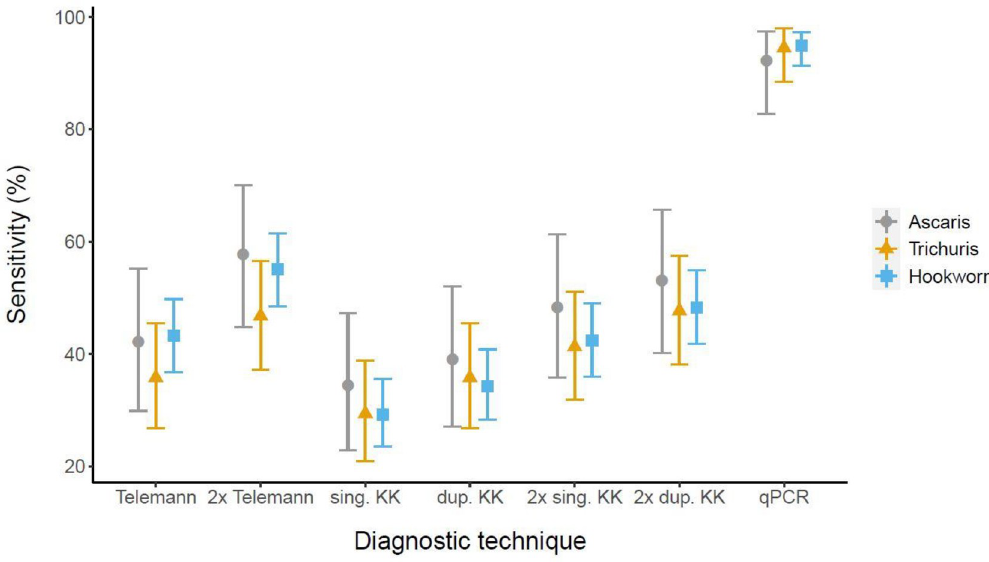
Fig 2. Estimated sensitivity and 95% confidence intervals [95% CI] of Telemann in one or two stool samples, single and duplicate Kato-Katz in one stool sample, single and duplicate Kato-Katz in two stool samples, multiplex qPCR compared to the composite reference standard (CRS) per A . lumbricoides , T . trichiura and